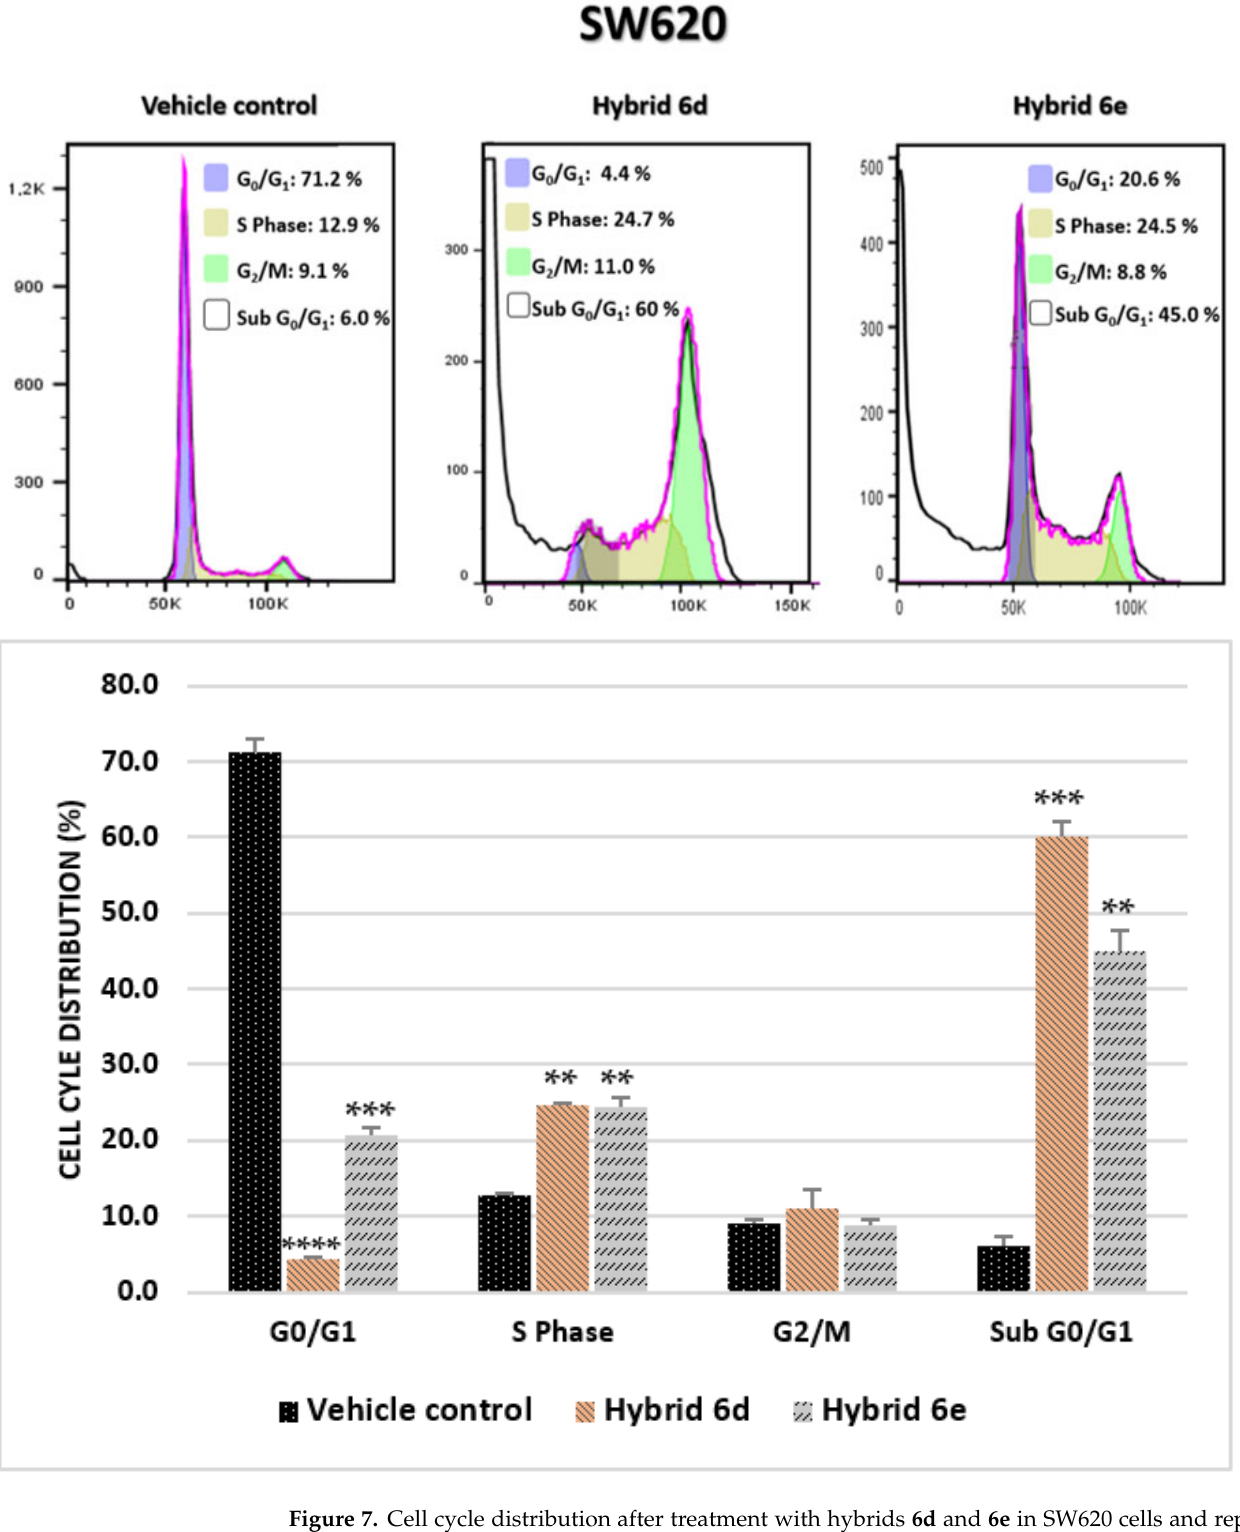
Figure 7. Cell cycle distribution after treatment with hybrids 6d and 6e in SW620 cells and repre- sentation of distribution percentages in bar chart form. All experiments were performed in duplicate and showed similar results. p -values lower than 0.05 were considered statistically significant (** p < 0.01; *** p < 0.001; **** p < 0.0001).